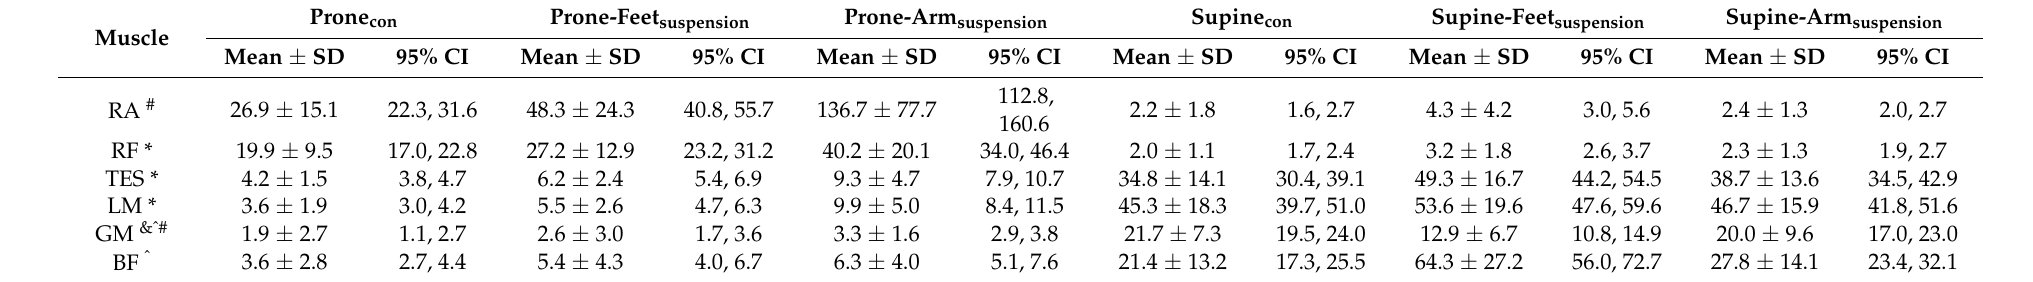
Table 2. Muscle activity (%MVC) during isometric bridge exercises under six different